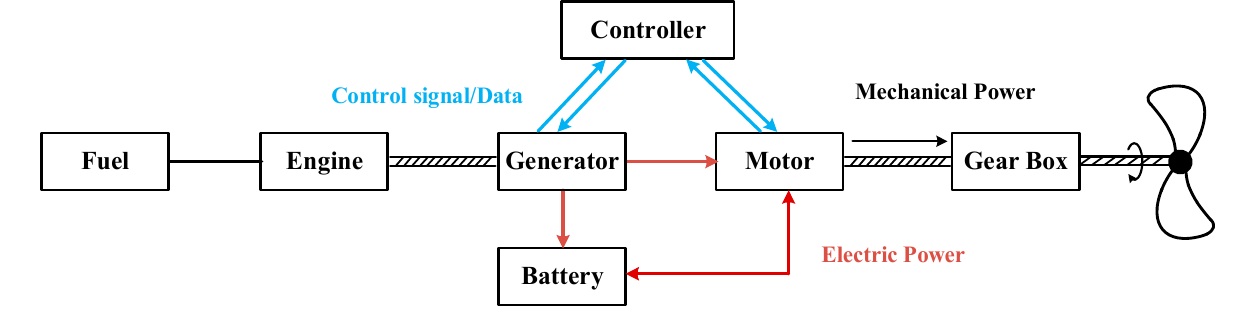
Figure 12. Series hybrid architecture.